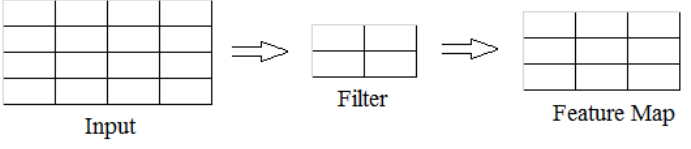
Figure 3. Convolution, filter, and feature map.